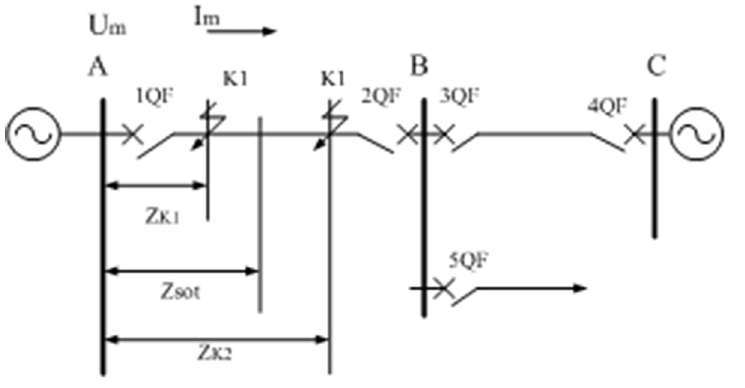
Fig 2. Principle of distance